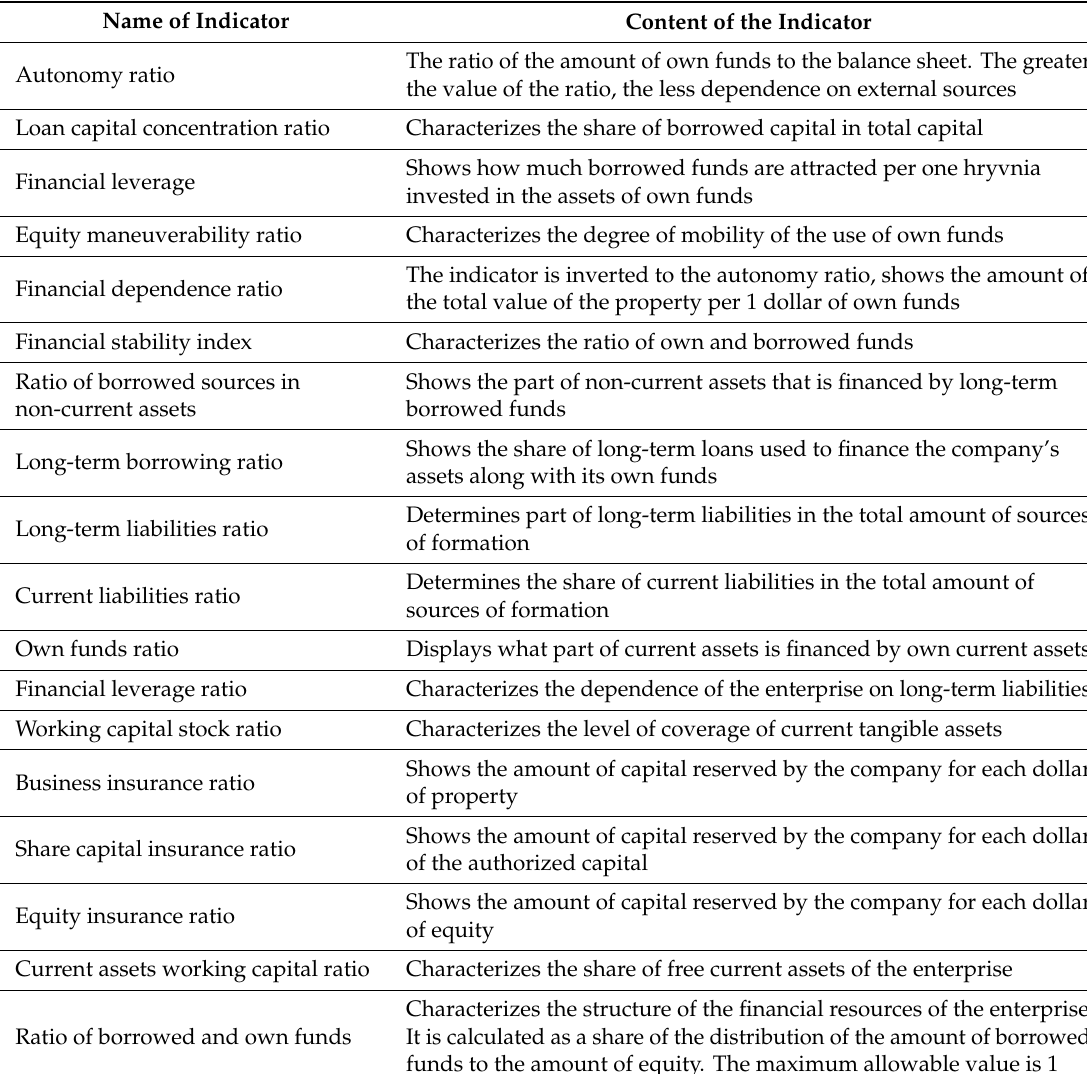
Table A1. Indicators for assessing the financial stability of the